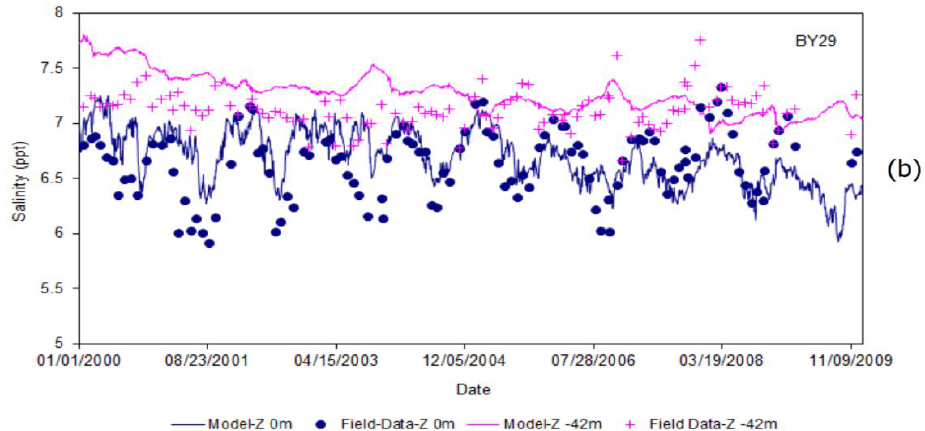
Figure 8. ( a ) Comparison of model predicted and measurements of temperature in the Baltic Sea at the Station BY29 surface and 42 m depth for the time period 2000-2009; ( b ) Comparison of model predicted and measurements of salinity in the Baltic Sea at the Station BY29 surface and 42 m depth for the time period 2000–2009.